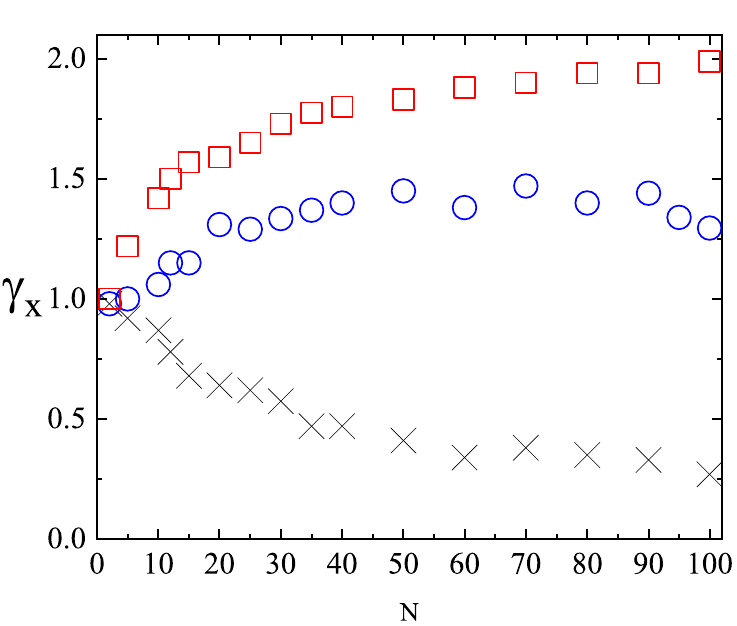
Figure 15. Exponent γ x as function of chain’s length N for the system without illumination (black crosses), homogeneous illumination with I 0 = 0.2 (blue circles) and inhomogeneous illu- mination with ∇ I = 0.005 (red squares). T = 0.25. Based on [163].